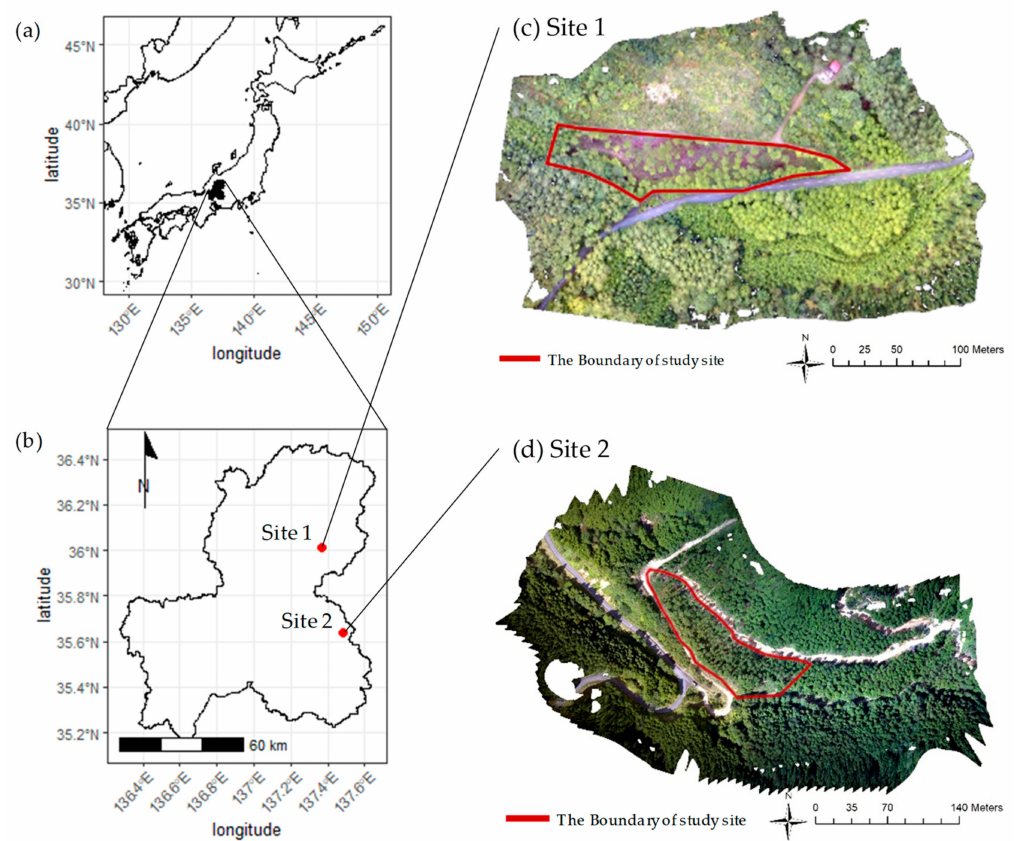
Figure 1. Location of study sites. ( a ) Gifu prefecture is located in the middle of Japan. ( b ) Red plots represent location of two study sites. ( c , d ) are orthographic photos of Site 1 and Site 2. Red lines show the boundary of study sites. Grey lines from east to west in Site 1 and from north west to south in Site 2 are roads and white paths in north east area in Site 1 and in east area in Site 2 are forest